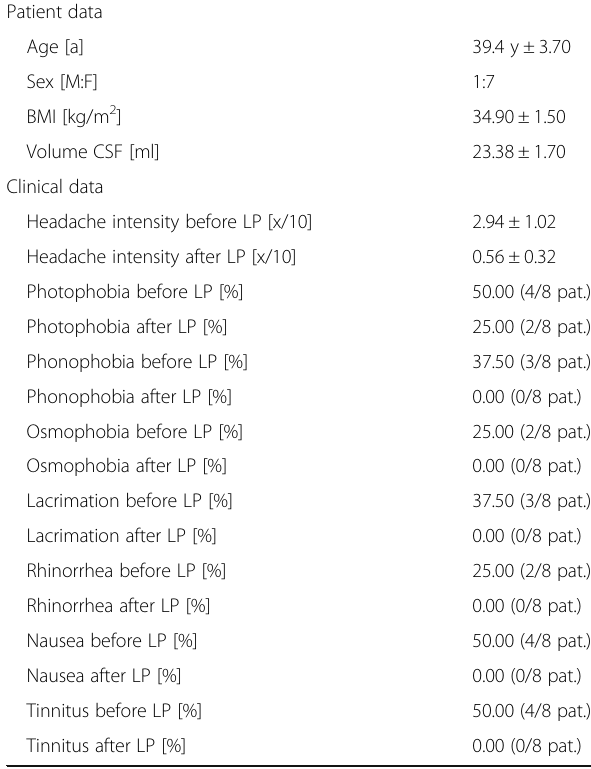
Table 2 Summarizes the characteristics of the study population as well as the characteristics of IIH-related headache and its accompanying features prior and after normalization of